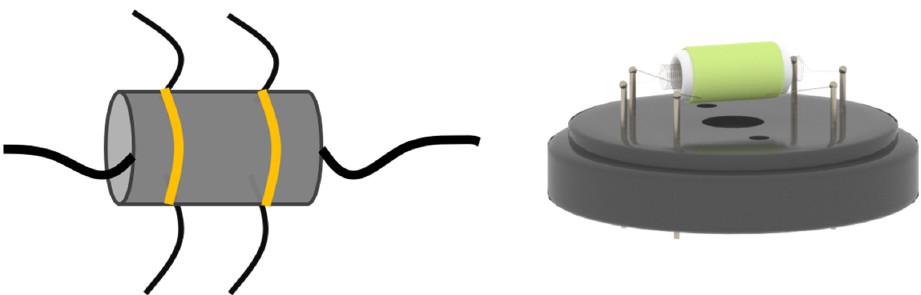
Figure 2. Structure illustration of the ceramic-tube-based SO 2 gas sensor.